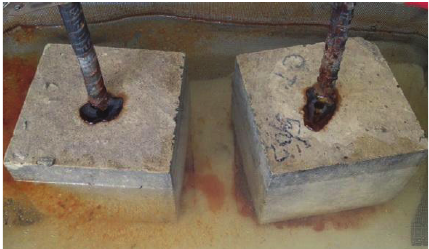
Figure 8: Relationship between compressive strength and porosity of SCC.